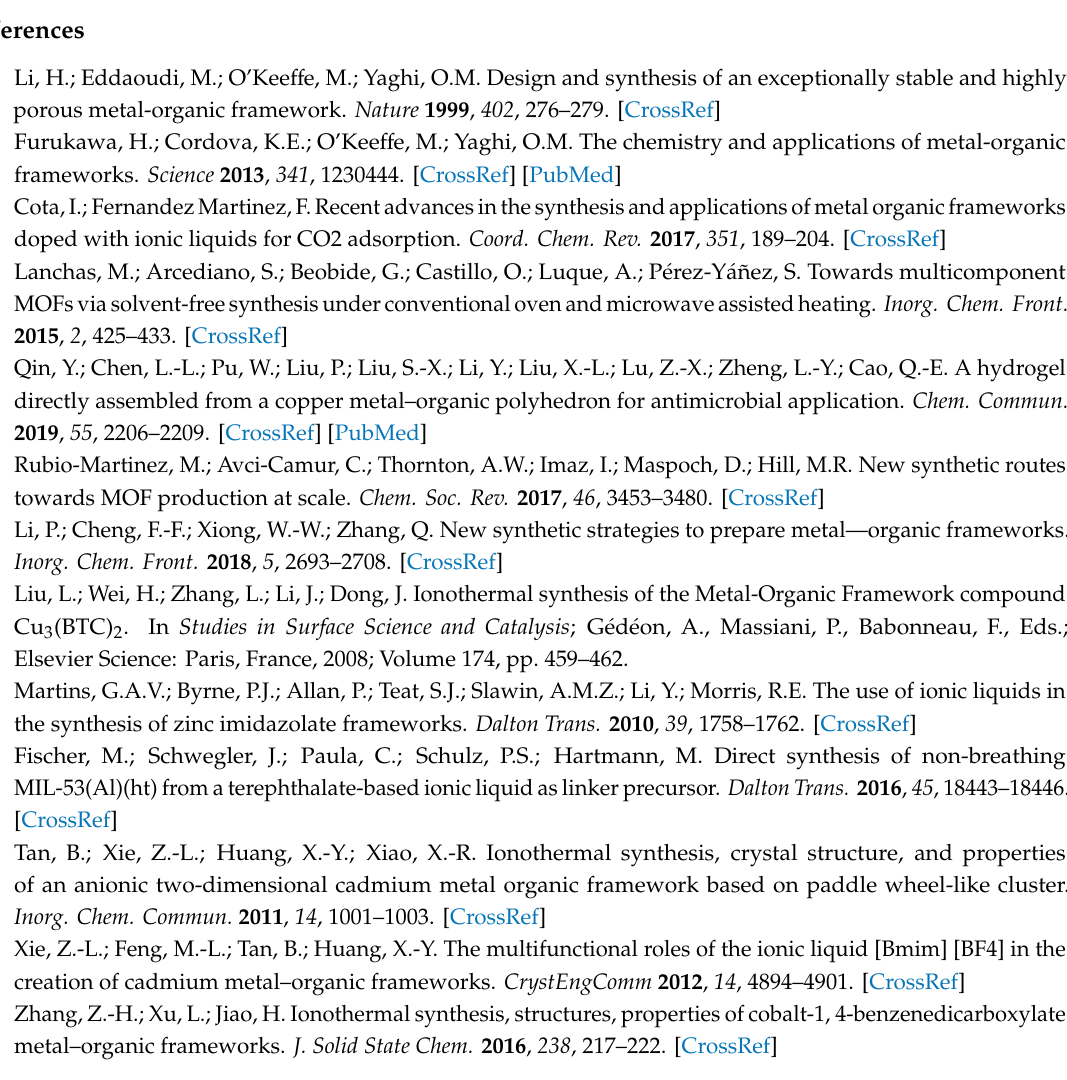
Figure S1: Powder X-ray di ff raction pattern-matching fittings for the samples of 1 synthesized (a) at 160 ◦ C, (b) at 190 ◦ C, and (c) at 190 ◦ C and washed with water; Figure S2: Powder X-ray di ff raction pattern-matching fittings for the samples of 2 synthesized at (a) 160 ◦ and (b) 130 ◦ C; Figure S3: Topological simplification of compound 1 ; (a) 3D view and (b) view of the [Cd 3 (ox)F 2 ] n2n + layers; Figure S4: Topological simplification of compound 2 ; Figure S5: 2D view of the thermo-di ff raction analysis of 2 ; Figure S6: Evolution of the cell parameter with the temperature for 2 ; Figure S7: Comparison of di ff ractograms of 2 , CdO and 2 heated up to 330 ◦ C; Figure S8: Representation of the crystal cells of the two components of the twin used for the X-ray di ff raction data collection of 2 ; Table S1 and S4: Fractional atomic coordinates and isotropic or equivalent isotropic displacement parameters (Å2) for 1 and 2 ; Table S2 and S5: Atomic displacement parameters (Å2) for 1 and 2 ; Table S3 and S6: Geometric parameters (Å, ◦ ) for 1 and 2